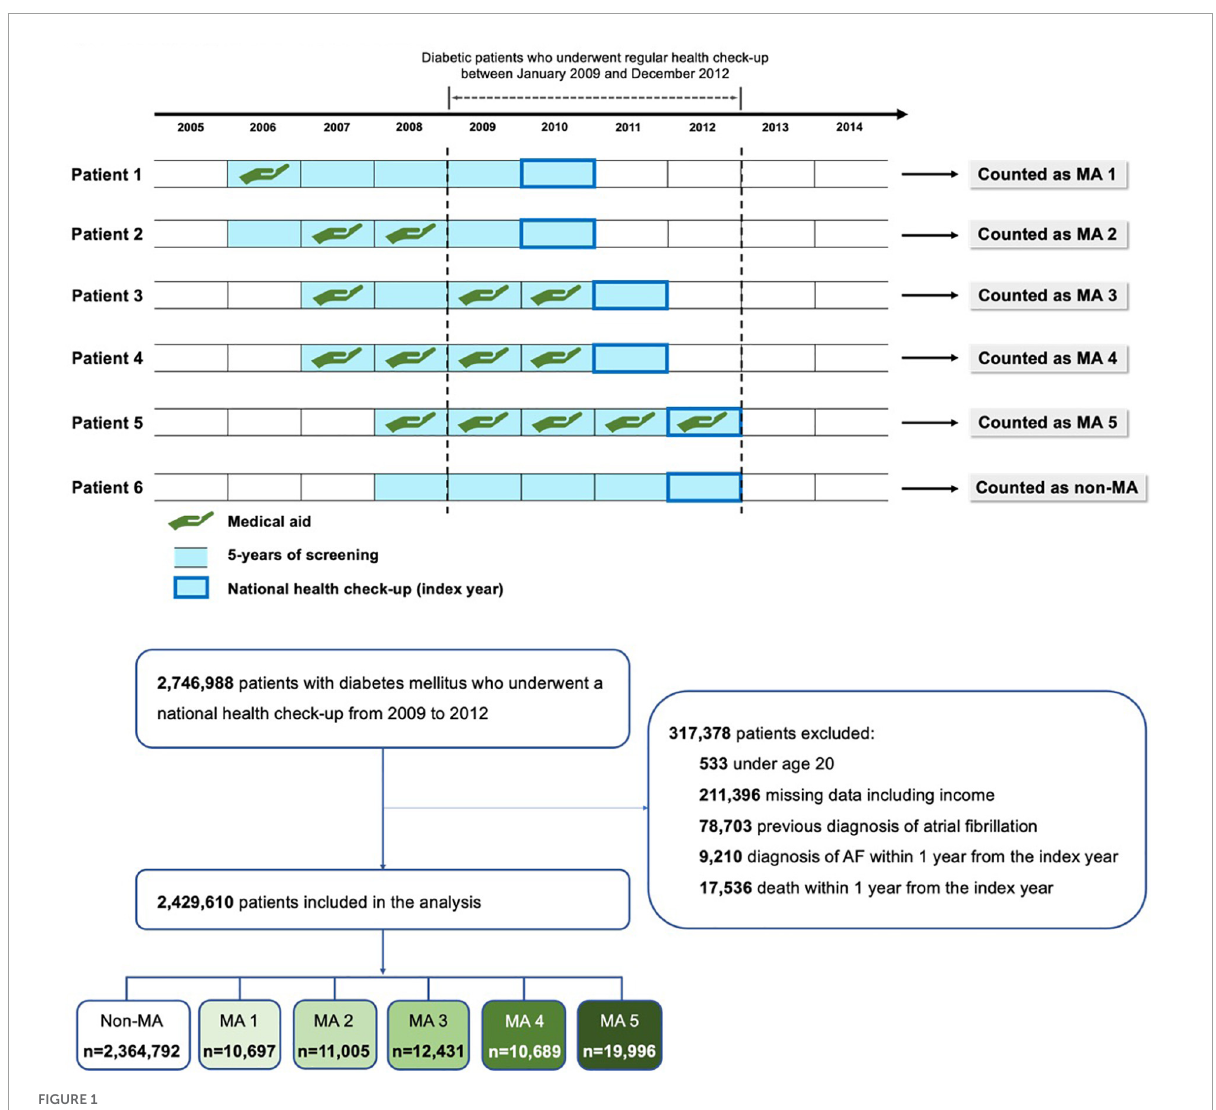
FIGURE1 Study design and flowchart of